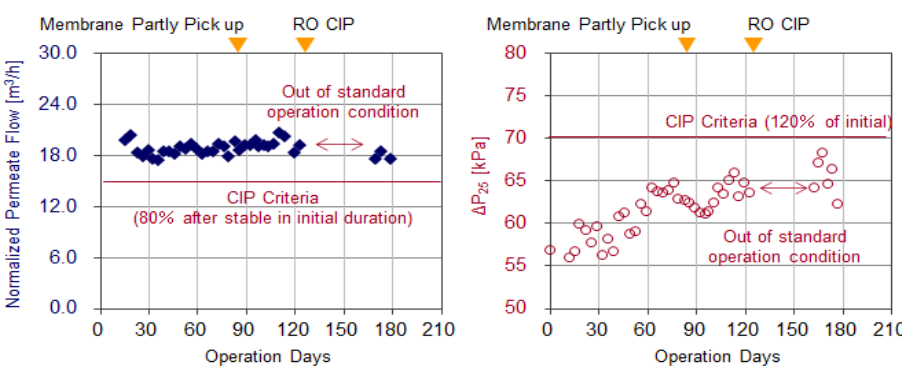
Figure 10. Changes in the normalized permeate flow rate and ∆ P 25